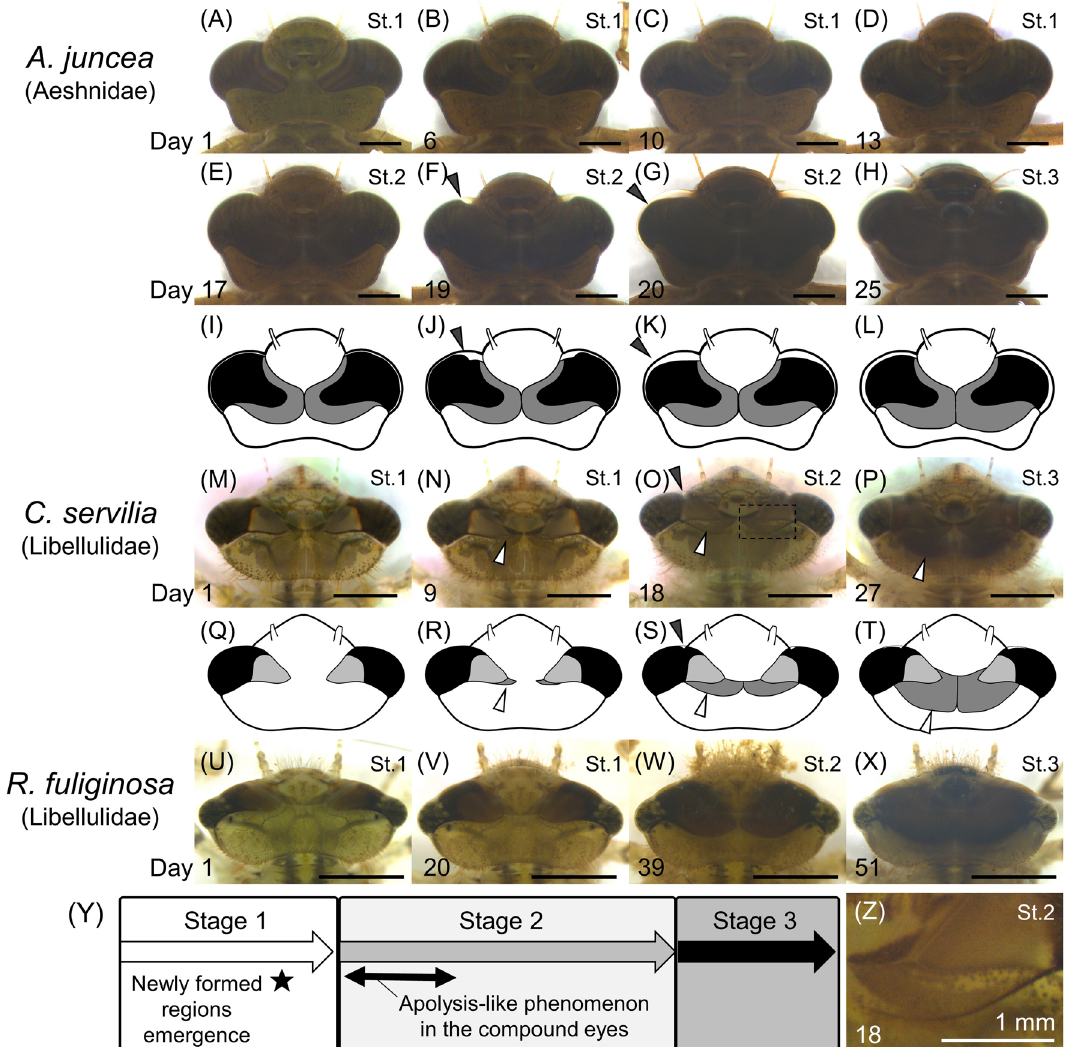
Figure 5. Morphological changes of the compound eyes during F−0 instar in Aeshnidae and Libellulidae larvae. ( A – X ) Dorsal views of the heads. All scale bars show 2 mm. Species and family names are provided on the left side. The number shown on the lower left of each image indicates the number of days after ecdysis to F−0 instar. Black arrowheads indicate the progression of the apolysis-like phenomenon in the compound eyes. White arrowheads indicate the newly formed regions of the compound eyes. ( I – L , and Q – T ) Schematic illustration of changes in shape and size of compound eyes. ( I – L ) or ( Q – T ) correspond to ( E – H ) or ( M – P ), respectively. ( A , M , U ) The first day of stage 1. ( E , I , O , S , W ) The first day of stage 2. ( H , L , P , T , X ) The first day of stage 3. ( N , R ) First day when the newly formed regions appeared. ( Y ) Schematic diagrams on the timing of the morphological changes during F−0 larval instar. ( Z ) Magnified view of the newly formed region in ( O Previous studies regarded the wrinkles on the wing sheaths (described as “accordion-like” 15 ) as an indica- tor of metamorphosis in Odonata 10,11,15,18 . In general, the wrinkles appeared a few days after the onset of stage 2 (Fig. 7C). While the wrinkles on the wings were clearly visible in many Odonata species (Fig. 7D,G, white arrowheads, Table 1), they were less obvious in some species (ex. Orthetrum albistylum : Fig. 7I–J). Just before adult emergence at the end of stage 3, the bristles on the body surface were melanized (Fig. 7K–L), although this change was often masked by dark pigmentation of the body surface. The degradation of larval labium, or shrinkage of tissues within the larval prementum, has been also used as an indicator of metamorphosis in Odonata 10,11,14,16 . We photographed the daily changes in the larval labium of 18 larvae representing 7 species (Table 1; Fig. S3). The degradation of larval labium was more prominent in dragonfly species (Anisoptera) (Fig. 7Q–Y) than in damselfly species (Zygoptera) (Fig. 7O–P,Z-b). We confirmed that the degradation of larval labium occurred from late stage 2 to stage 3 (Fig. 7Q-c, white arrowheads). It should be noted that the changes in larval labium were not prominent in some species like Tanypteryx pryeri (Petaluridae, Fig. 7M–N) and I. senegalensis (Coenagrionidae, Fig. 7O–P).